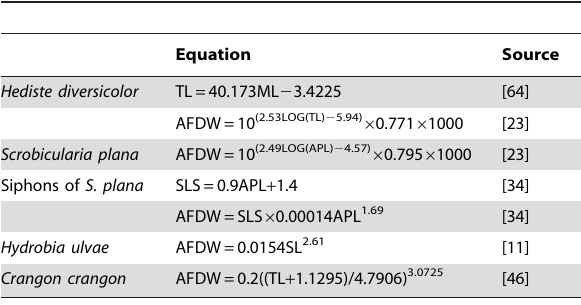
Table 1. Equations used to calculate biomass (ash free dry weight, AFDW) of Dunlin invertebrate